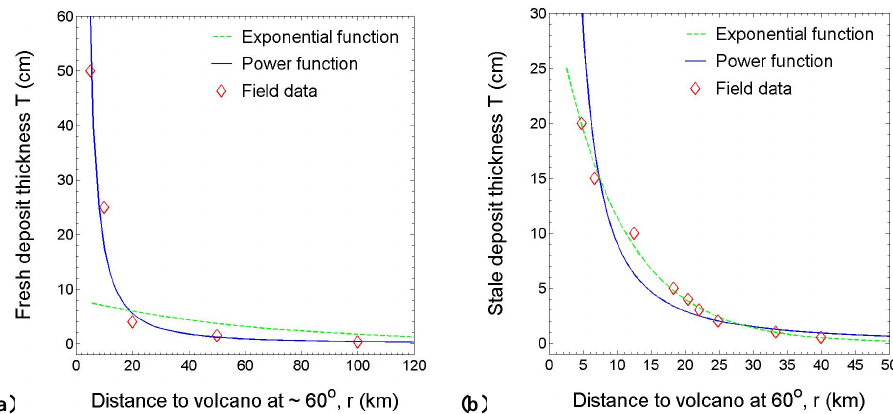
Fig. 3. Ashfall deposit thickness vs. distance data for the 28 March 1982 El Chich´on eruption. (a) Best fittings along a radial line at 60 ◦ (counterclockwise respect to the wind axis) of fresh ash deposits measured a few days after the 28 March 1982 eruption (diamonds) with the power function (Eq. 3) (solid line, C r =-0.995), and with the exponential function (Eq. 4) (dotted line, C r = − 0 . 845). (b) Thickness and best fits along a radial line at 60 ◦ (counterclockwise respect to the wind axis), of the same deposits measured several months later (diamonds) with the exponential function (Eq. 5) (dotted line, C r = − 0 . 997) and with the power function (Eq. 6) (solid line, C r = − 0 . 950). All of the data in Table 2 are used for the inversions, but only the closest (120km) data are shown in the figure for clarity.